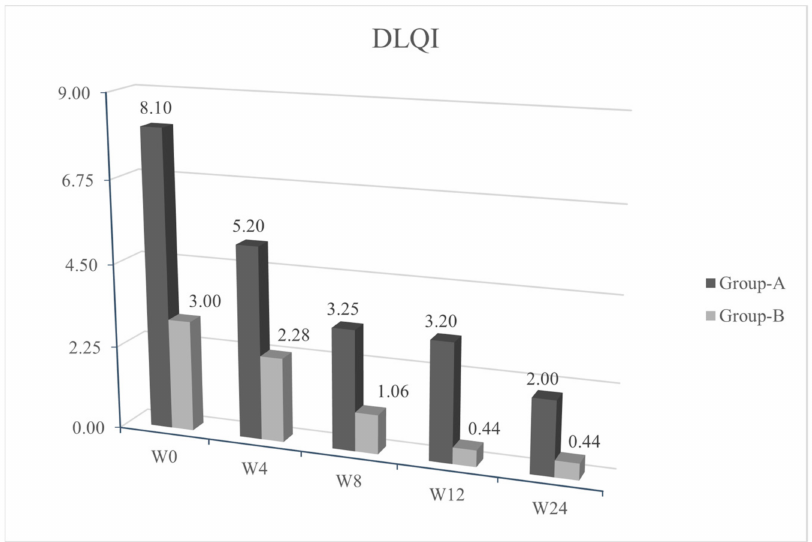
Figure 2. Average values of Dermatologic Quality of Life Questionnaire (DLQI) ( y ) in the various evaluation timings ( x ). p ≤ 0.05 at